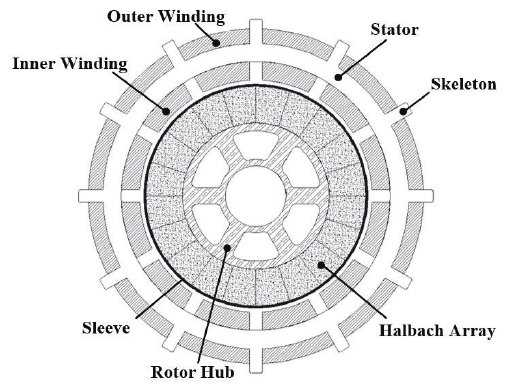
Figure 2. The cross-sections of the